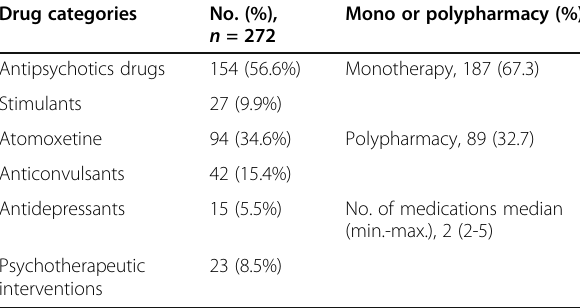
Table 2 Distribution of psychotropic drug prescription